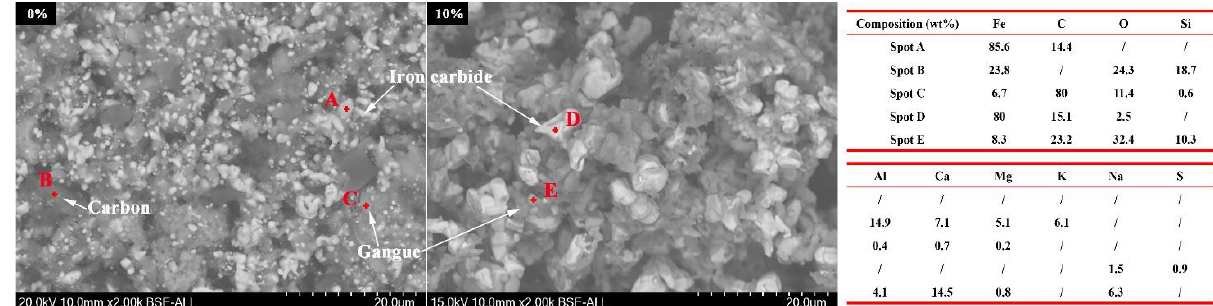
Figure 5. XRD patterns of carburized pellets with various Na 2 SO 4 weight percentages.